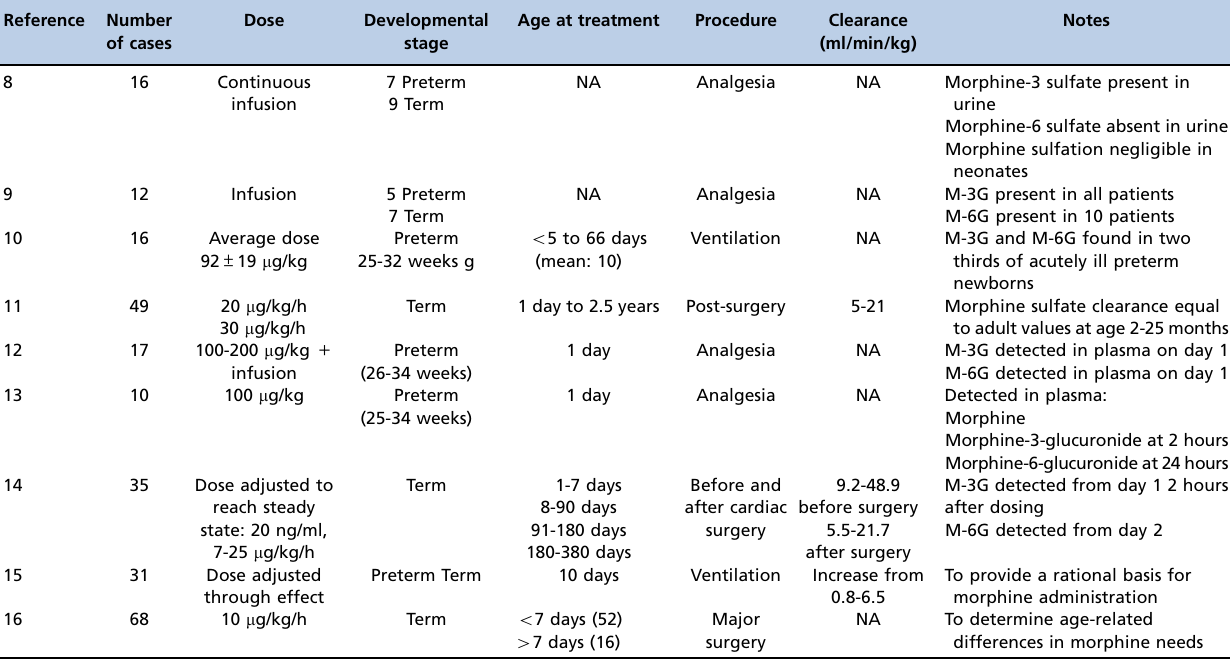
Table 1 - Metabolic parameters of morphine in neonates. The figures are means. The adult values are normal and are used for comparison. Reference Number of